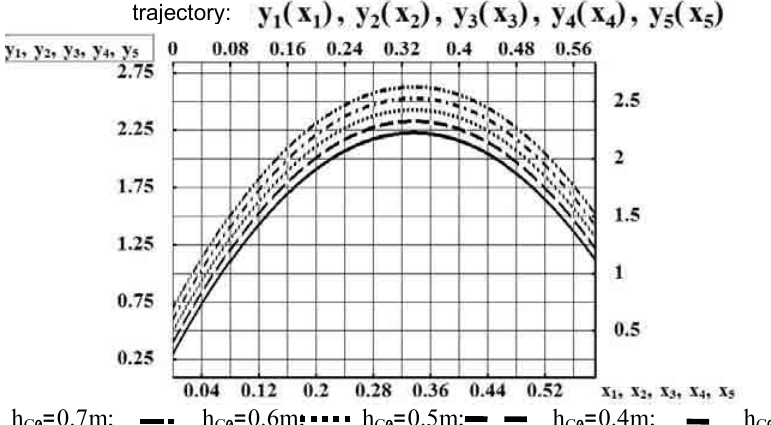
h C 0 = 0.7m; Fig.5. Characteristic curves of body masses center’s trajectory for different values of body masses height during